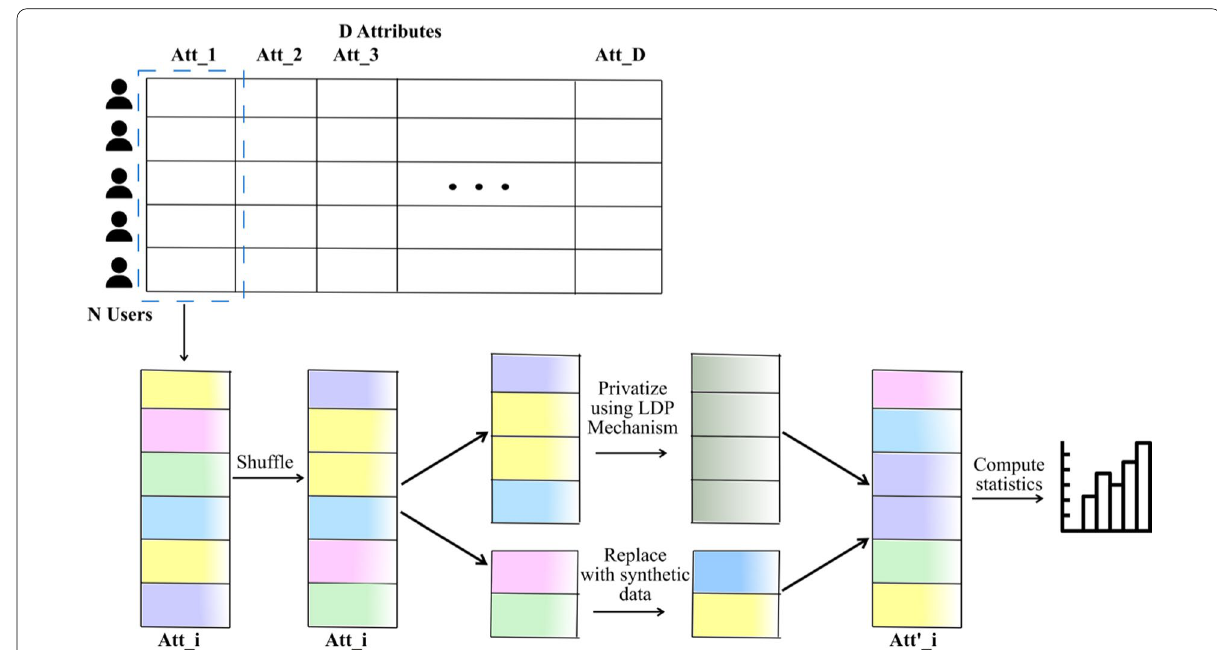
Fig. 1 A schematic of the RS FD framework proposed by Arcolezi et al. that formed the basis of the proposed solution +